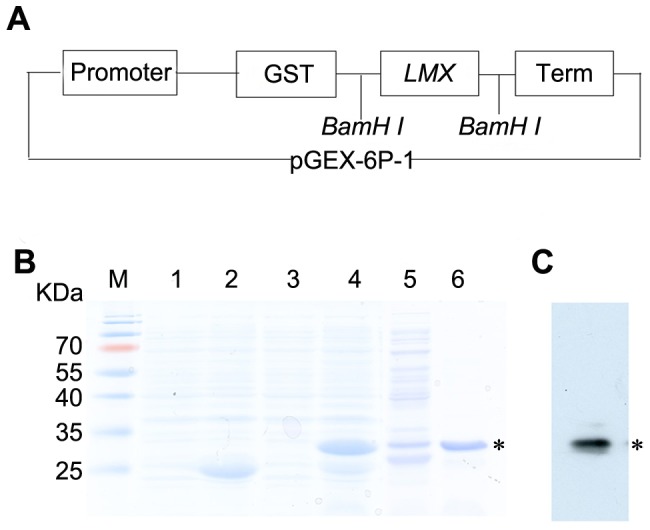
Expression and purification of the LMX protein in E. coli.
A. Schematic representation of the expression vector pGEX-6P-1-LMX. B. Coomassie stained polyacrylamide gel (12%). M, molecular weight marker (SM0671, Fermentas); line 1–2, total protein extracts of pGEX-6P-1 without IPTG induction and with IPTG induction; line 3, total protein extracts of pGEX-6P-1-LMX without IPTG induction; line 4–5, supernatant and inclusion bodies of pGEX-6P-1-LMX with IPTG induction; line 6, purified sample of supernatant of pGEX-6P-1-LMX with IPTG induction. * represents the target band. C. Western blot probed with an antiserum raised against the purified GST-LMX fusion protein. The Molecular mass of polypeptides expressed by the GST-LMX recombinant construct was about 32.8 kDa.